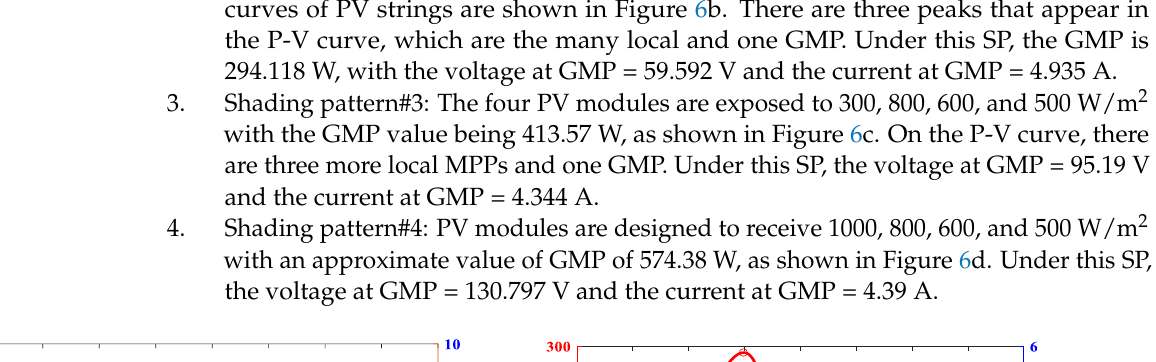
Table 1. Four shading patterns with four different GMP under study.